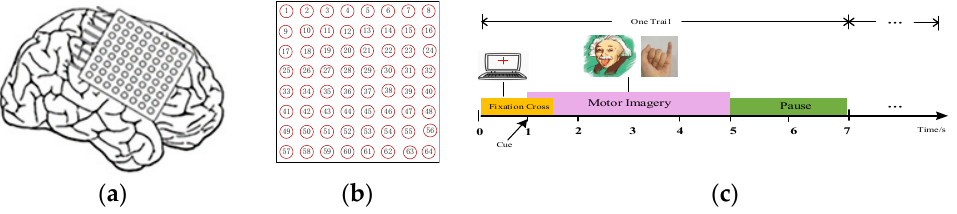
Figure 2. ( a ) The locations of the primary motor cortex. ( b ) The positions of 64 channels. ( c ) The timing of the motor imagery paradigm.